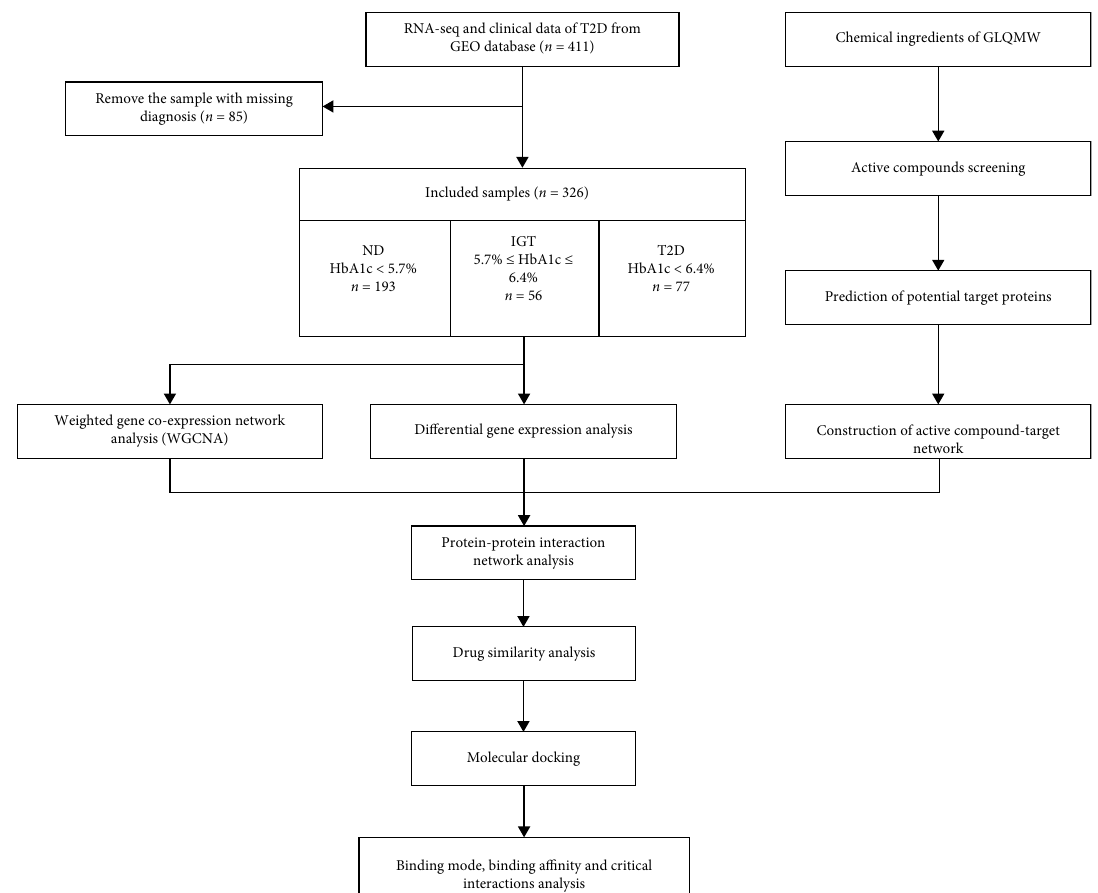
Figure 1: Experimental design for elucidating the mechanisms of action of GLQMW in the treatment of